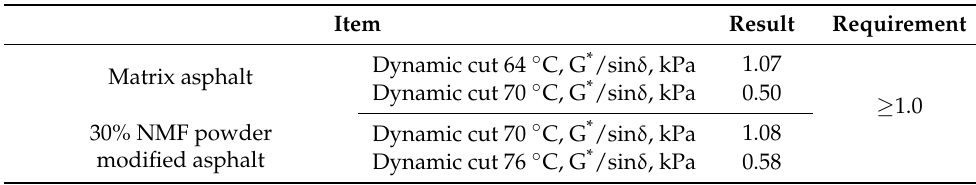
Table 4. High-temperature grade of PG classification.